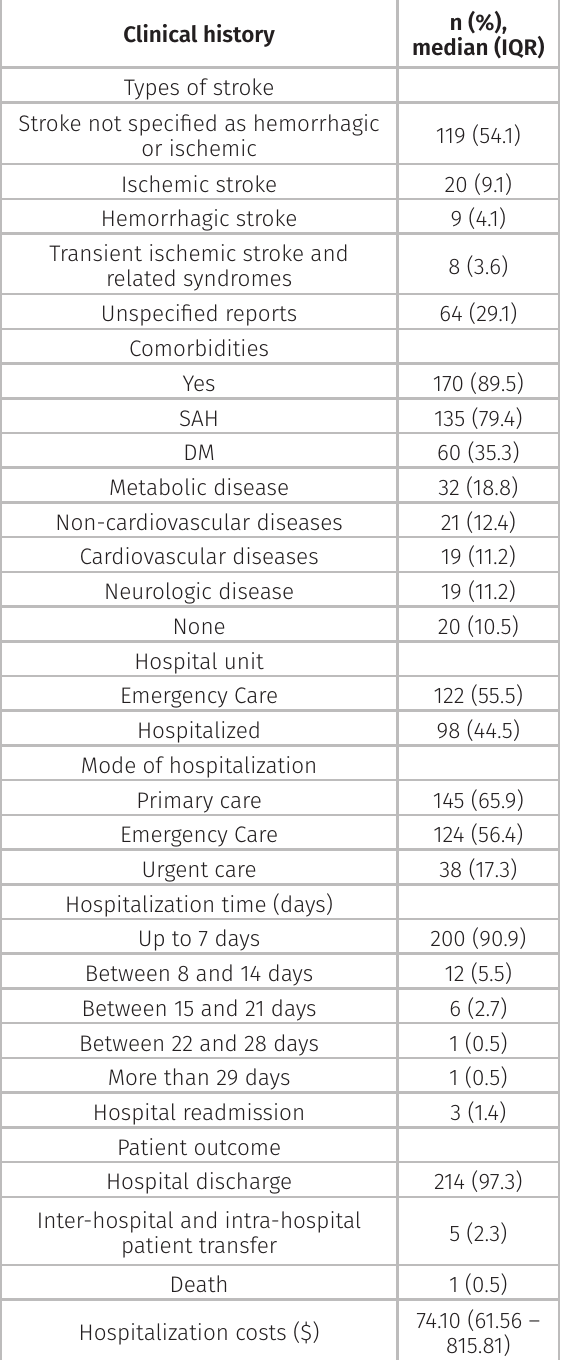
characteristics in adult population admitted by stroke diagnosis in a private hospital in Southern